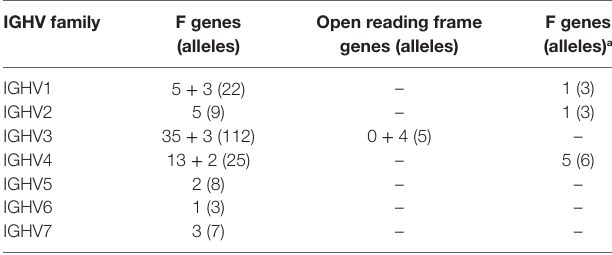
TaBle 1 | List of all functional and ORF IGHV genes and alleles in the IGHV allele library.